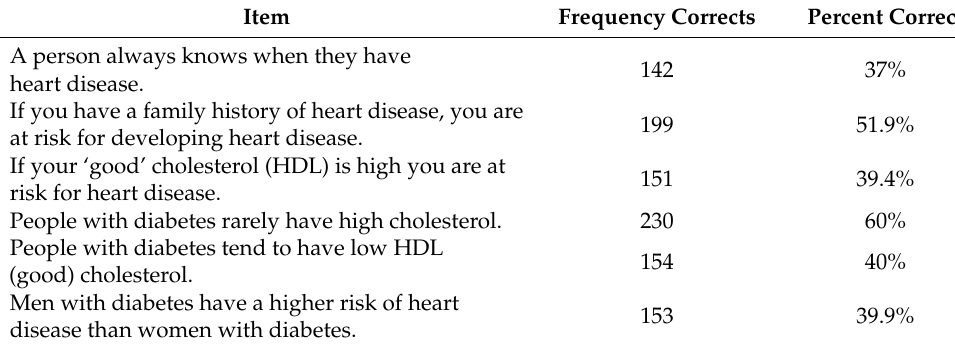
Table 3. Heart Disease Fact Questionnaire items with less than 70% correct response.